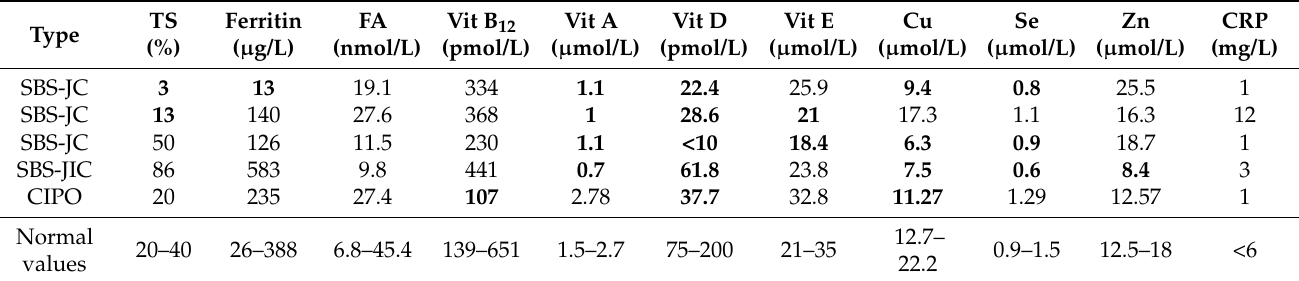
Figure 2. Individual changes in albumin for SBS-JC and SBS-JIC patients during IVS and FU. ( A ) SBS-JC and ( B ) SBS-JIC patients restarting IVS during FU are indicated in red (albumin <30 g/L during FU). Abbreviations: follow-up (FU), short bowel syndrome (SBS), jejuno-colic anastomosis (SBS-JC), and jejuno-ileal anastomosis (SBS-JIC). Table 4. Micronutrients in SBS patients restarting IVS during